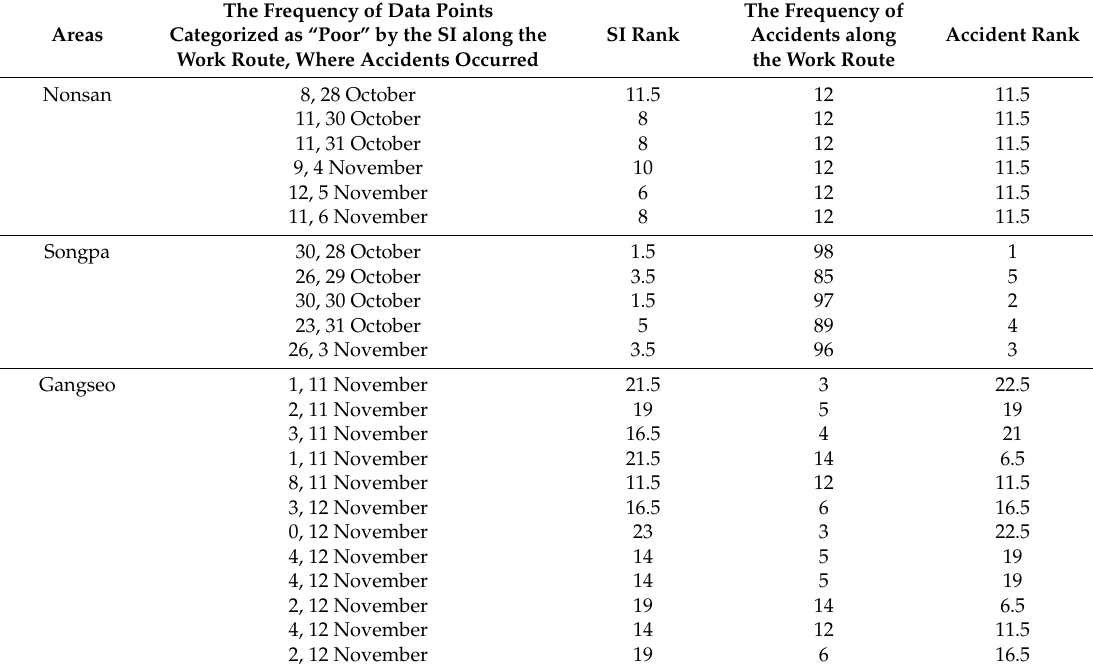
Table 10. Comparison between two rankings obtained by two sets of data: one is the frequency of data points categorized as “Poor” by the safety index (SI) along the work route, where accidents occurred; the other is the frequency of accidents along the work